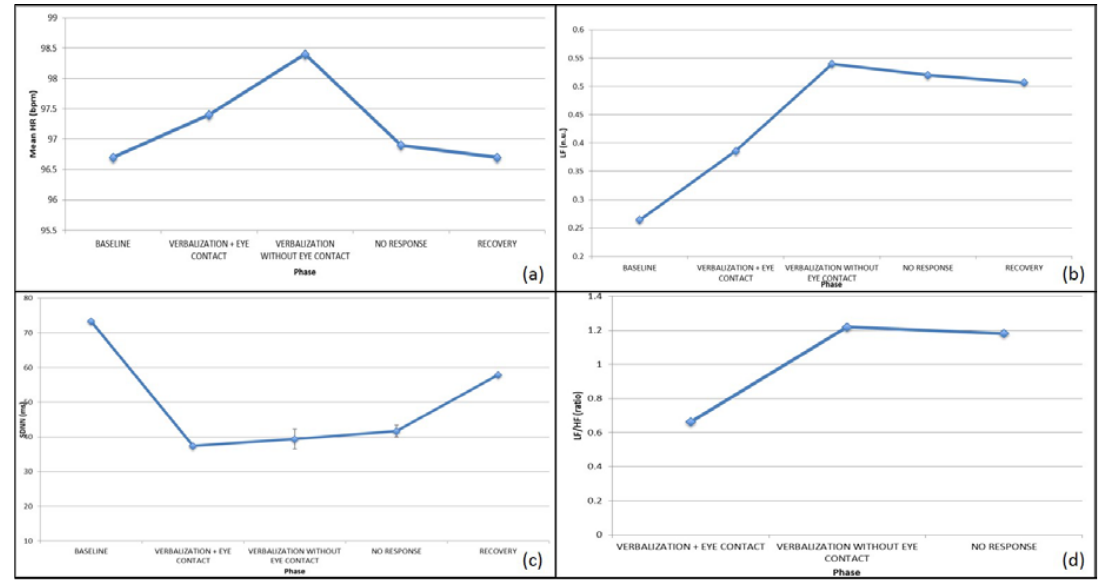
Figure 3. ECG features for J. during the various phases of the graphical trace: ( a ) HR, ( b ) LF, ( c ) SDNN, ( d ) LF/HF.